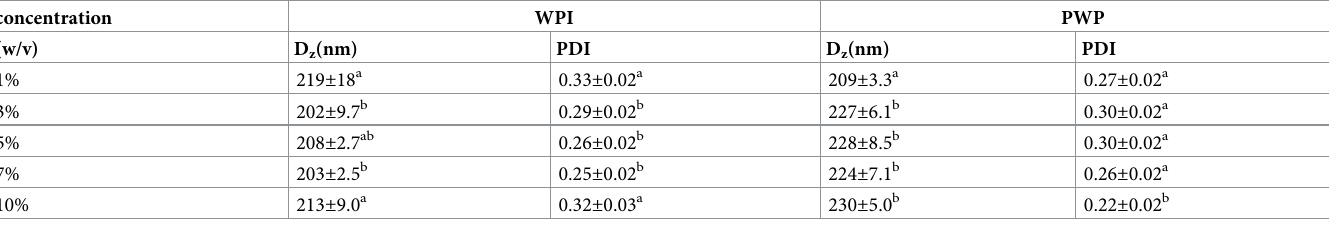
Note: Value = mean ± SEM, n = 3; only values with different lowercase letters were considered significantly different within the same column at p < 0.05. Lutein content was 2.5 mM in tested emulsions.